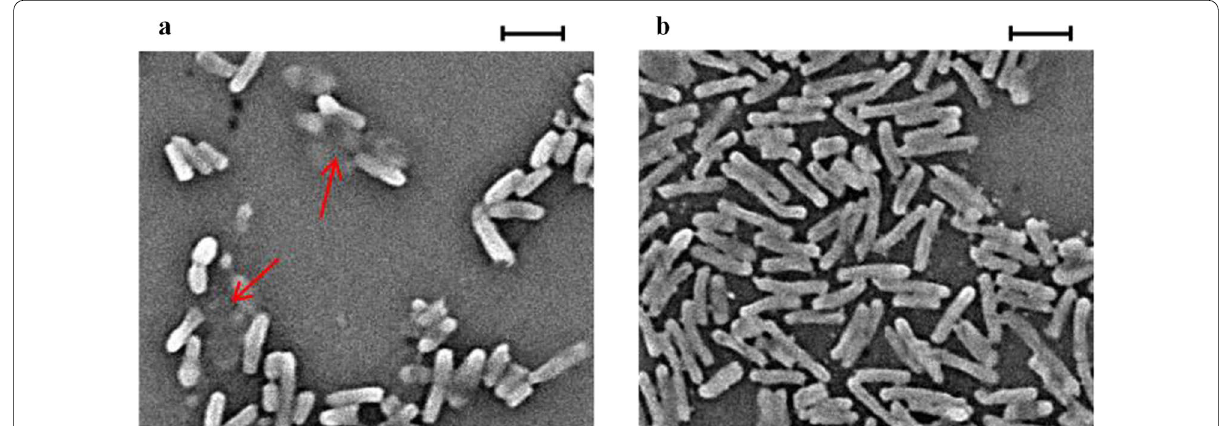
Fig. 5 Scanning electron micrographs of BL- control and BL- fpd after 4-FP treatment. a View of BL- control treated with 4 mM 4-FP for 12 h (average cell length: 1.639 μm). The location of viscous substances attached to the cell surface was marked by red arrow; b View of BL- fpd treated with 4 mM 4-FP for 12 h (average cell length: 1.921 μm, P < 0.05); SEM operating parameters: 15 kV 7.2 mm